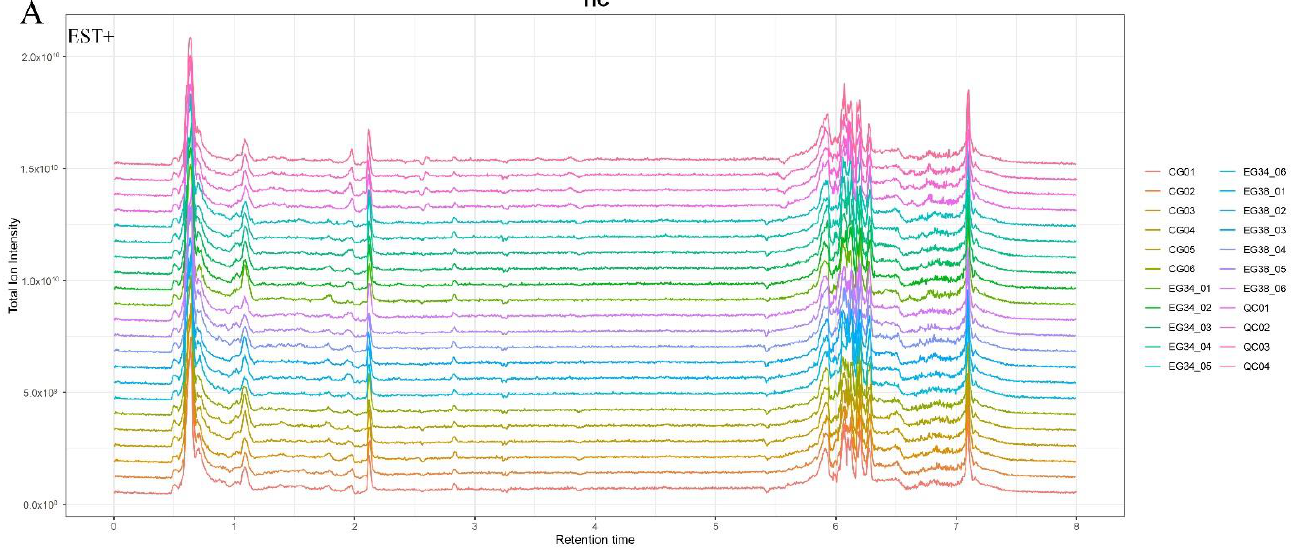
Figure 2. The total ion current (TIC) of liver samples from Cyprinus carpio var qingtianensis measured in ( A ) positive (ESI+) and ( B ) negative (ESI −) modes. CG01 – CG06: six samples from control group; EG34_01 – EG34_01: six samples from experimental group (34 °C) under thermal stress; EG38_01 – EG38_06: six samples from experimental group (38 °C) under thermal stress; and QC01 – QC04: four samples from quality control group. 3.2. Statistical Analysis of Data After the data were normalized, unsupervised multivariate analysis (PCA) and supervised analysis (OPLS-DA) were used to evaluate the quality control (QC) samples and other investigational samples. Principal component analysis (PCA) was performed on the data set and showed that all groups were within the 95% confidence interval (Hotelling ’ s T-squared ellipse). In positive and negative modes, the PCA model ’ s R 2 X predictive ability values were 0.434 and 0.402, respectively, indicating that the information was statistically trustworthy (Figure 3). Therefore, a PLS-DA model was used to further investigate how the groups differed. The parameter R 2 Y denotes the model’ s interpretation rate, and Q 2 denotes the model ’ s prediction rate. Typically, a parameter larger than 0.4 is necessary for a viable model. The results of the OPLS-DA score plots for